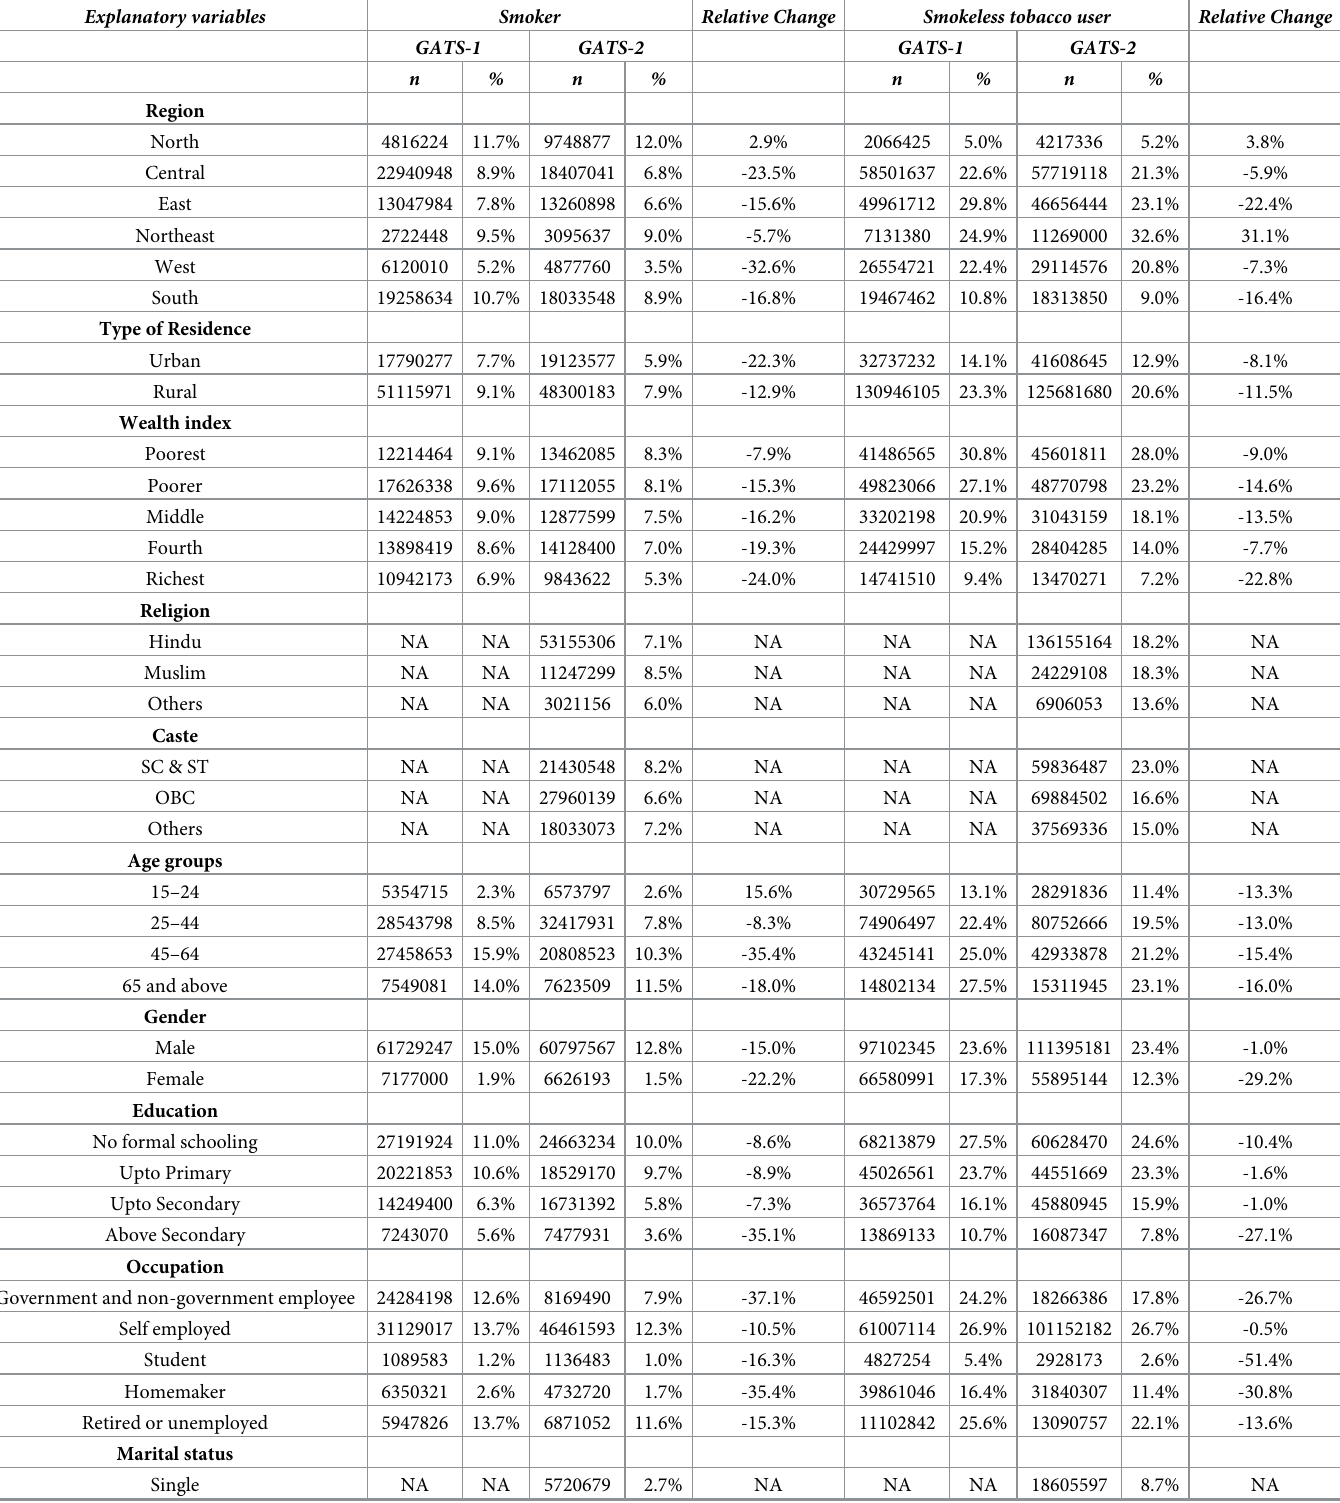
Table 1. Prevalence of smoking and smokeless use of tobacco according to selected background characteristics in India, GATS-2009-10 and GATS-2016-17. Explanatory